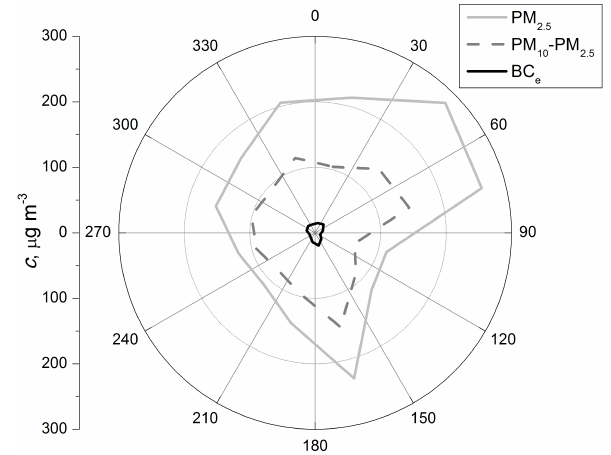
Fig. 11. Average PM 2 . 5 -, coarse mode-, and BCe masses according to the main trajectory sector. Data from the rainy season is not